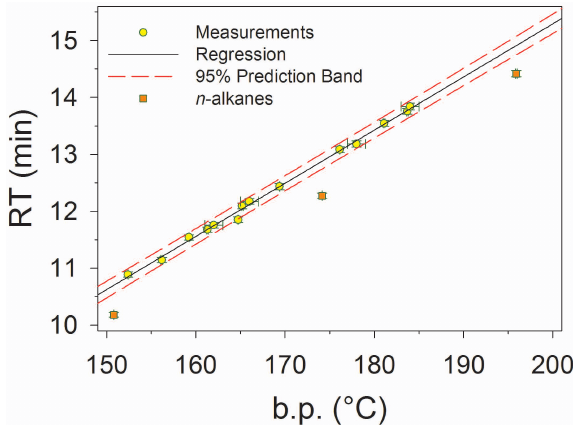
Fig. 1. Linear correlation between elution order (retention time) and boiling point for C 9 –C 11 compounds in the THF GC system primary working standard that eluted from the VF-5ms column be- tween nonane and undecane. The regression line was derived by a simple least squares analysis which excluded data for the n -alkanes. Error bars are 0.04–0.06 min, representing 3 σ of the mean values determined from standard chromatograms, and 0.01–1 ◦ C (taken to be 1 unit in the least significant digit of the literature b.p.